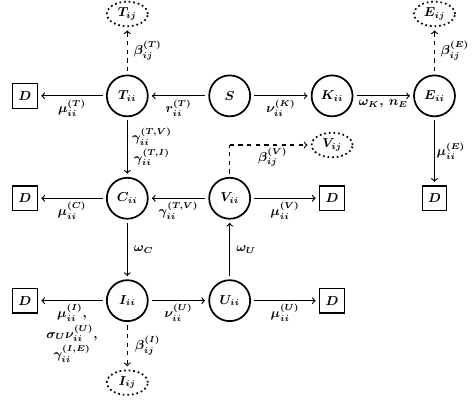
1 Figure 2. Scheme of the model for a single lymph node N